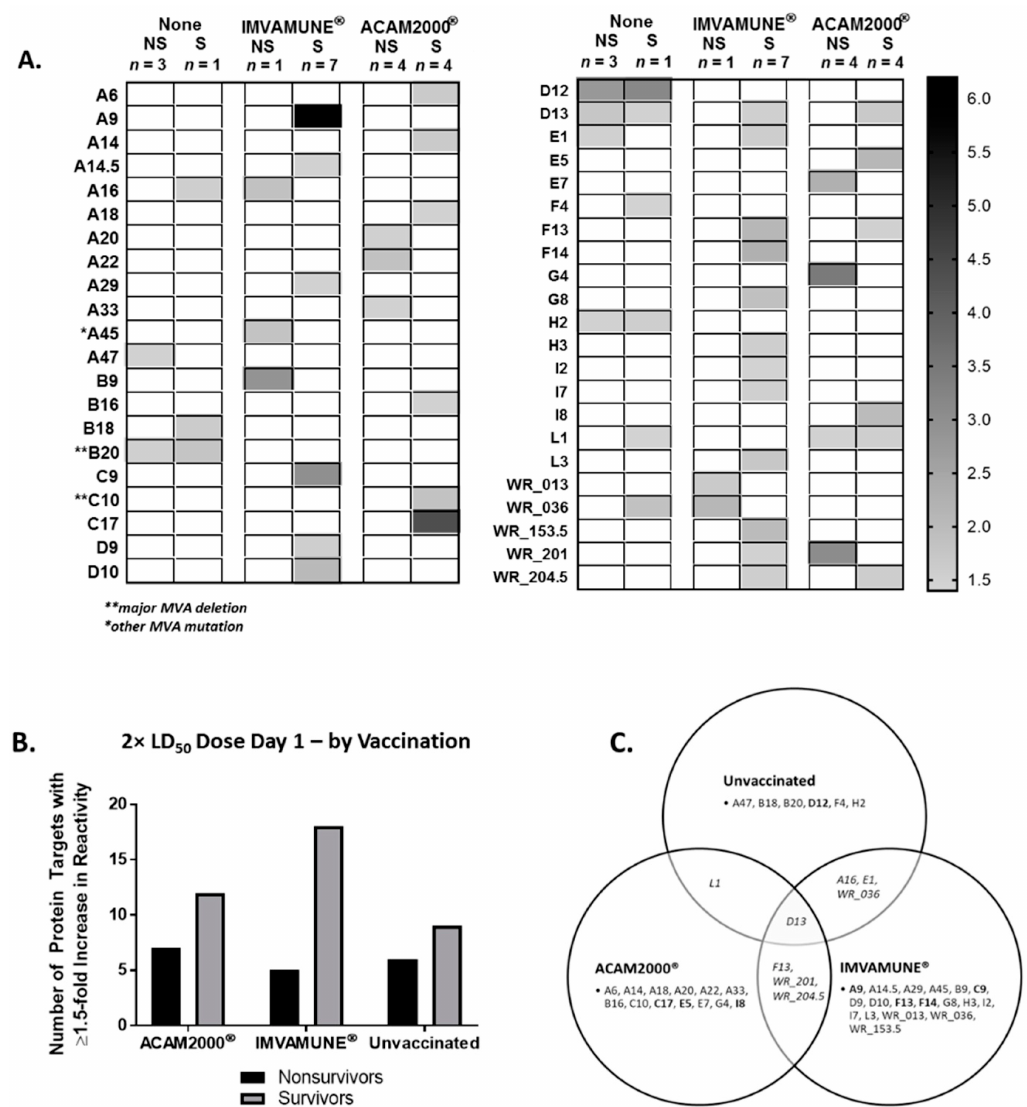
Figure 7. Protein targets for antibody response determined by proteome microarray. Sera from animals challenged with a 2 × LD 50 dose of monkeypox virus and vaccinated 1 day postexposure were analyzed by microarray. Proteins where fold-increases in reactivity were ≥ 1.5 are displayed as a heat map ( A ) with average fold-increase for unvaccinated (Columns 1 and 2), IMVAMUNE ® -vaccinated (Columns 3 and 4), and ACAM2000 ® -vaccinated (Columns 5 and 6) nonsurvivors (odd numbered columns) and survivors (even numbered columns). The total number of protein targets with a ≥ 1.5 fold-increase in reactivity with animal serum is shown for all groups of animals ( B ), subgrouped by survivors (gray column) and nonsurvivors (black column). The Venn diagram ( C ) describes the overlap of protein targets with a ≥ 1.5 fold-increase in reactivity among the groups, with the most reactive targets per group highlighted